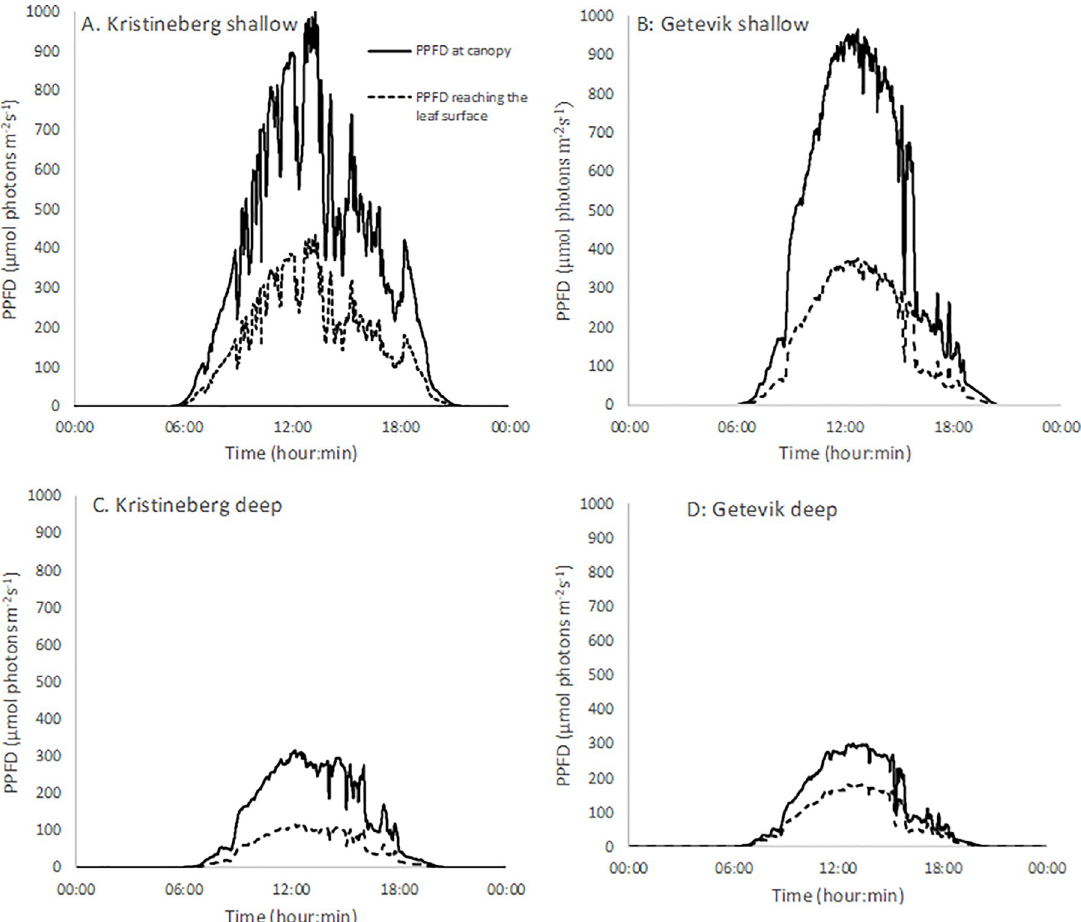
Fig 5. PPFD measured by the light loggers at the seagrass leaf canopy (solid line), and the estimated light interception at the seagrass leaves (PPFD intercepted ) calculated from the average %PPFD intercepted in Table 1 (broken